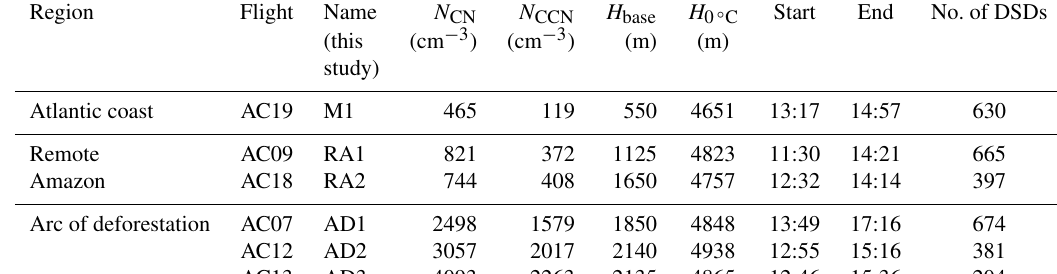
Table 1. General characteristics of the cloud profiling missions of interest to this study: condensation nuclei ( N CN ) and CCN concentrations ( N CCN , with S = 0.48 ± 0.033%), cloud base and 0 ◦ C isotherm altitude ( H base and H 0 ◦ C , respectively), start and end time, and total number of DSDs collected. The data are limited to the lower 6km of the clouds. The unit for N CN and N CCN is per cubic centimeter and the unit for altitude is meters. Profile start and end are given in local time. The names in the third column have the following meaning: M1 – Maritime 1; RA1 and RA2 – Remote Amazon 1 and Remote Amazon 2; AD1, AD2, and AD3 – Arc of Deforestation 1, Arc of Deforestation 2, and Arc of Deforestation 3.